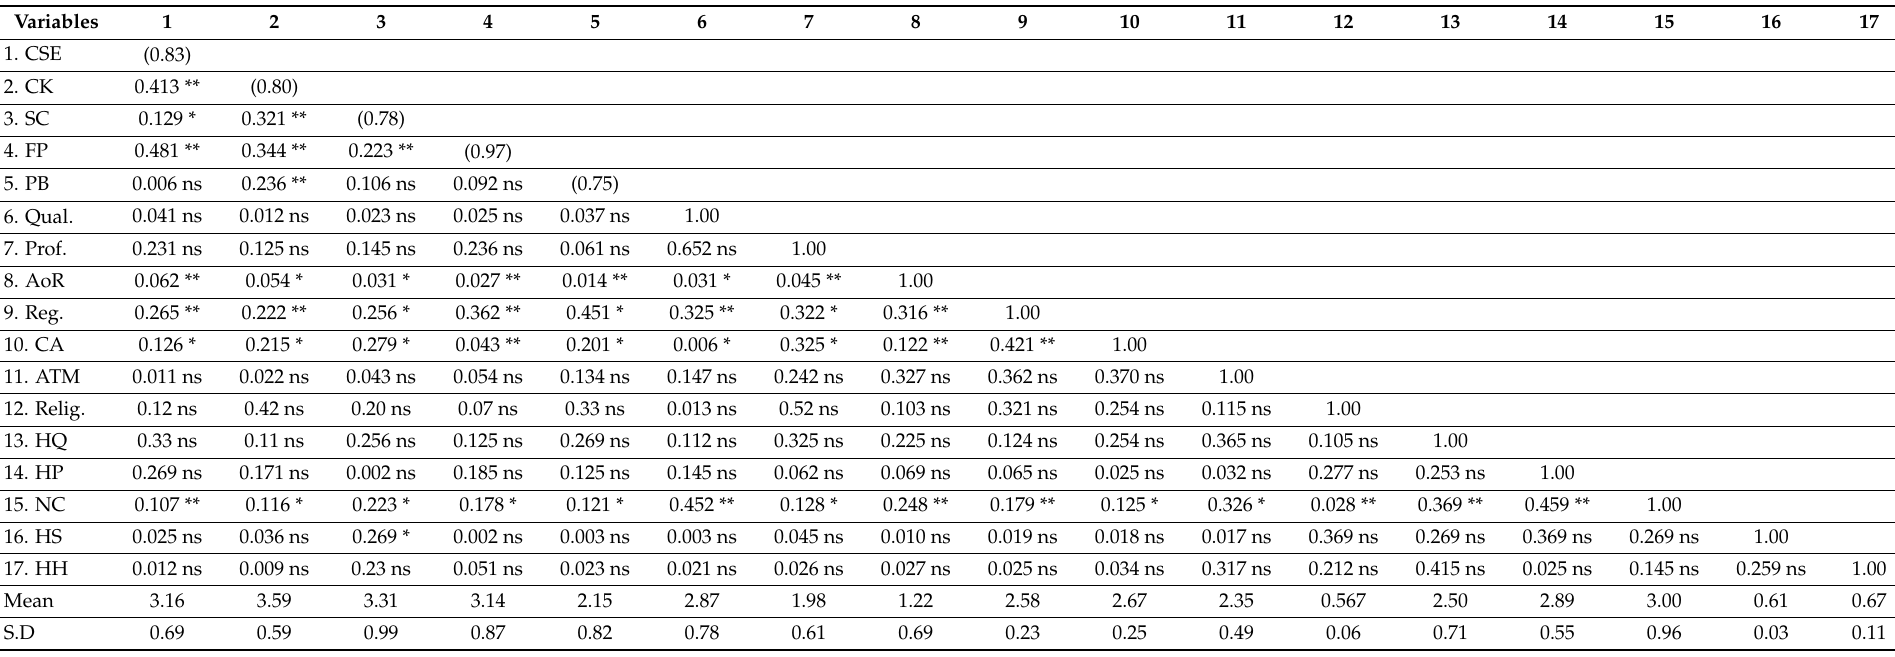
Table 3. Means, standard deviations, correlations, and